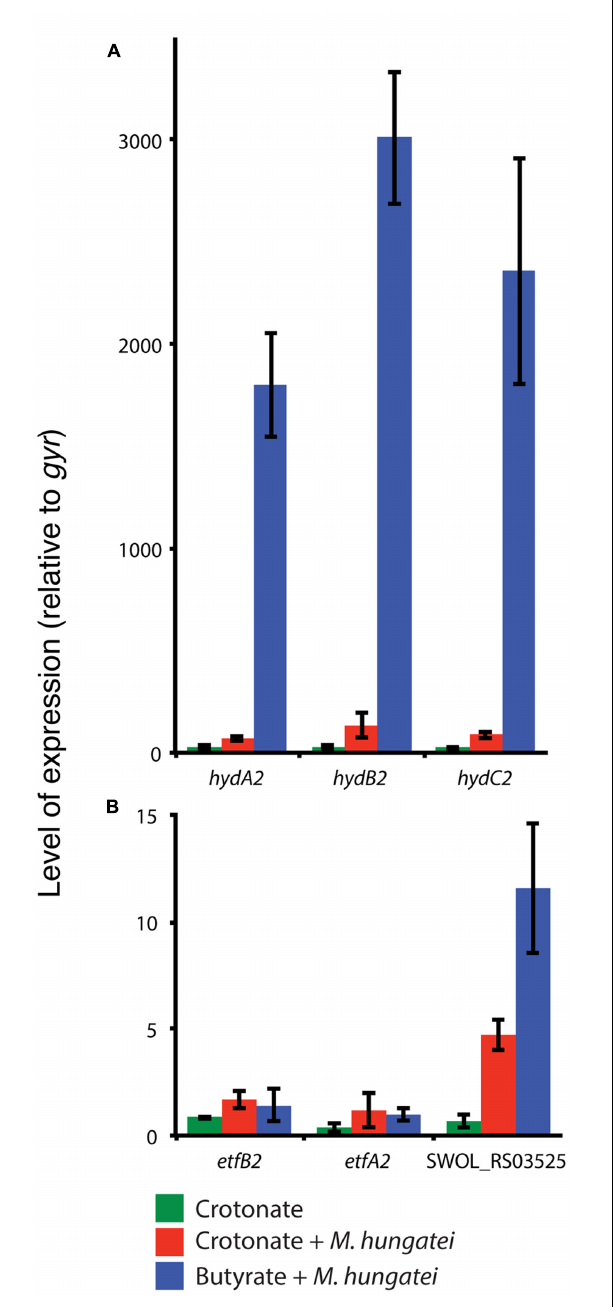
FIGURE 1 | Expression of hydABC2 (SWOL_RS09950, SWOL_RS09955 and SWOL_RS09960) (A) , etfAB2 (SWOL_RS03515 and SWOL_RS00520) and SWOL_RS03525 (FeS oxidoreductase) (B) genes in S. wolfei grown in axenic culture on crotonate (green), in co-culture with M. hungatei on crotonate (red) or in co-culture with butyrate